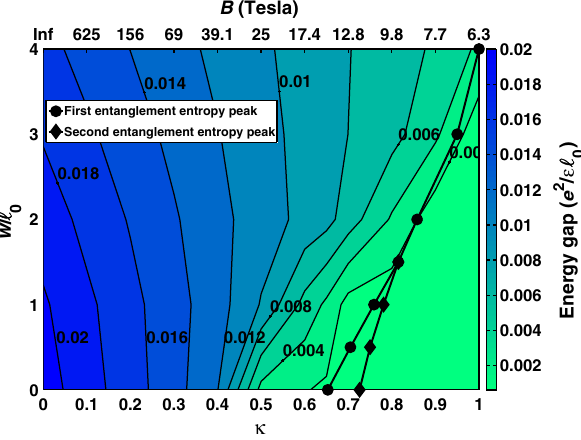
FIG. 14. Quantum phase diagram obtained from a color map of the energy gap (difference between the two lowest eigenstates for the system with N ϕ ¼ 33 ) plotted versus well width and κ . Contours plot specific values of the extrapolated gap. Lines with black circles and black diamonds show the positions of the entanglement entropy peaks for N ϕ ¼ 29 and represent the approximate phase boundaries. All the states to the left from the line connecting the black circles belong to the MR Pfaffian universality class. The top x axis is the magnetic field for GaAs samples. All results are obtained on the